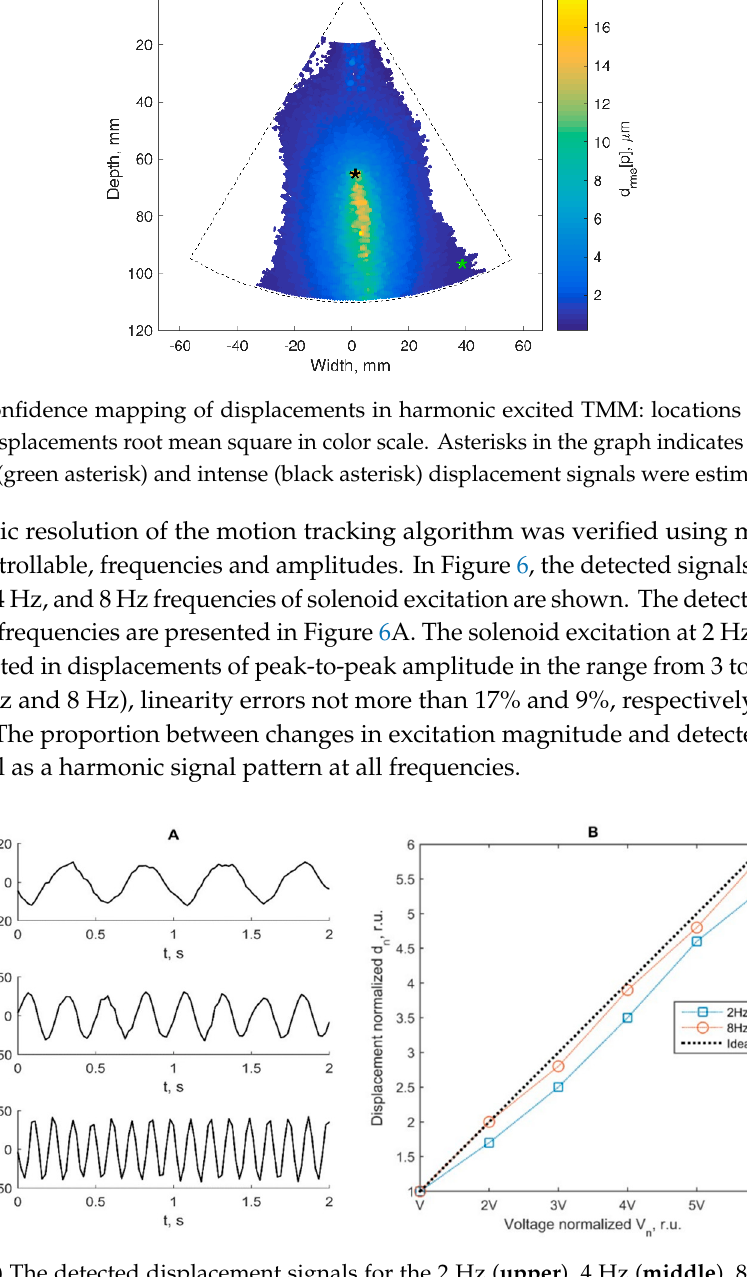
Figure 6. ( A ) The detected displacement signals for the 2 Hz ( upper ), 4 Hz ( middle ), 8 Hz ( lowest ) solenoid excitation frequencies; ( B ) detected displacements resulting from proportional changes in excitation amplitude of the solenoid. The dashed line represents the ideal theoretical case of detection. Excitation peak-to-peak voltages were 0.5 V, 1 V, 1.5 V, 2 V, 2.5 V, and 3 V at frequencies of 2 Hz and 8 Hz.